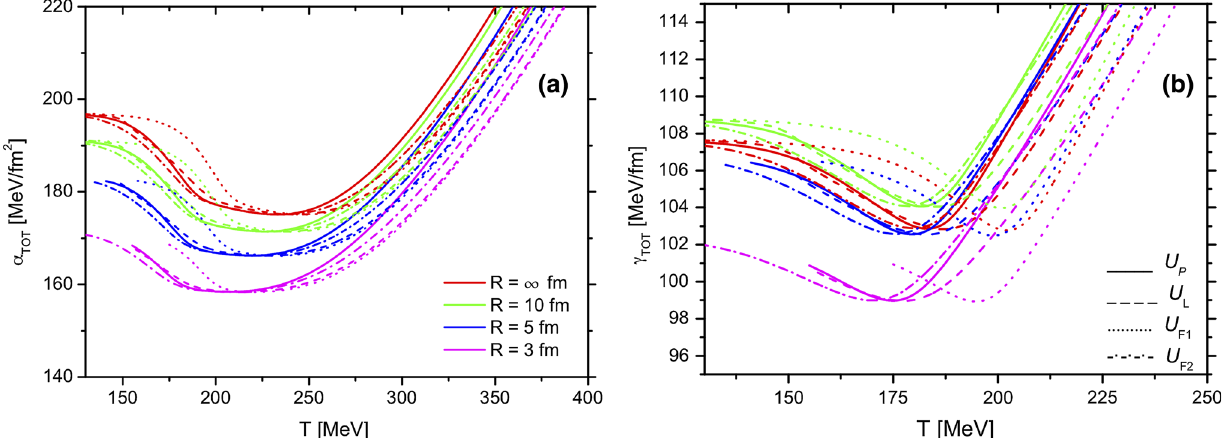
Fig. 7 Total surface tension and total curvature energy as a function of temperature; the scales of panels ( a ) and ( b ) are different. The minimums of α TOT and of γ TOT occur at different